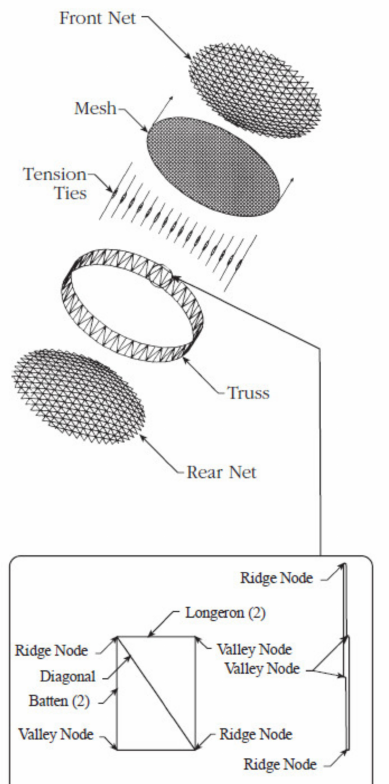
Figure 1. An illustration of the AstroMesh